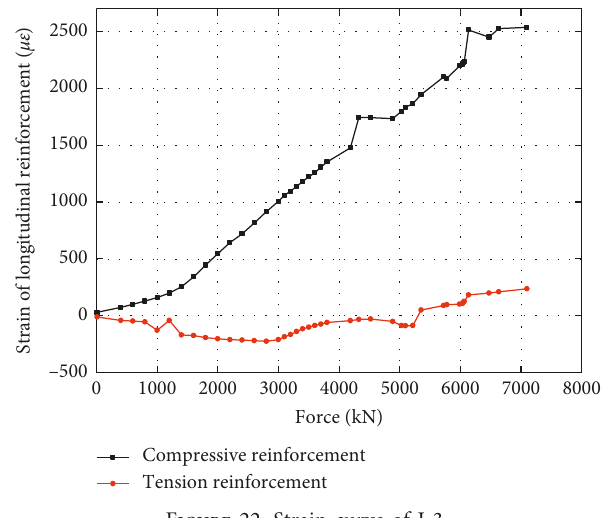
Figure 22: Strain curve of Table 5: Comparison and analysis of results. Theoretical results Specimen (kN)